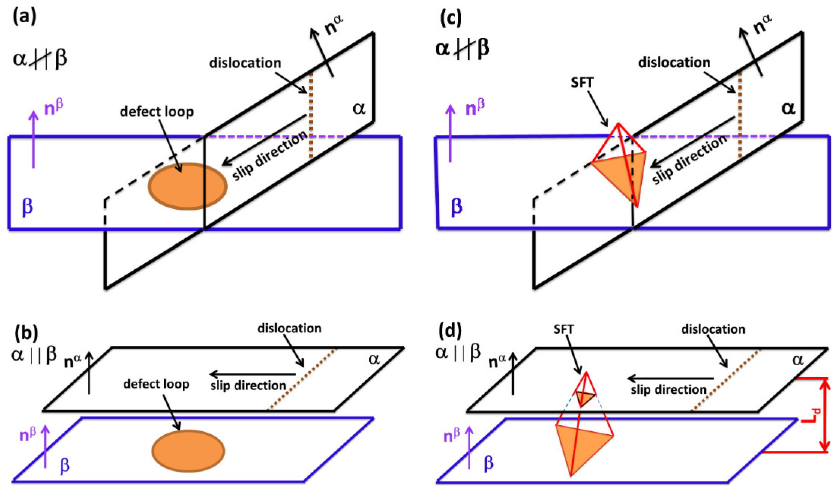
Figure 5. (color online) Illustration of the dislocation-DL and dislocation-SFT interaction when their slipping planes and habit planes are parallel or not. ( a ) The slipping plane of dislocations is not parallel to the habit plane of DLs; ( b ) the slipping plane of dislocations is parallel to the habit plane of DLs; ( c ) the slipping plane of dislocations is not parallel to the habit plane of SFTs; and ( d ) the slipping plane of dislocations is parallel to the habit plane of SFTs. (Reprinted with permission from [106]. Copyright 2015 by